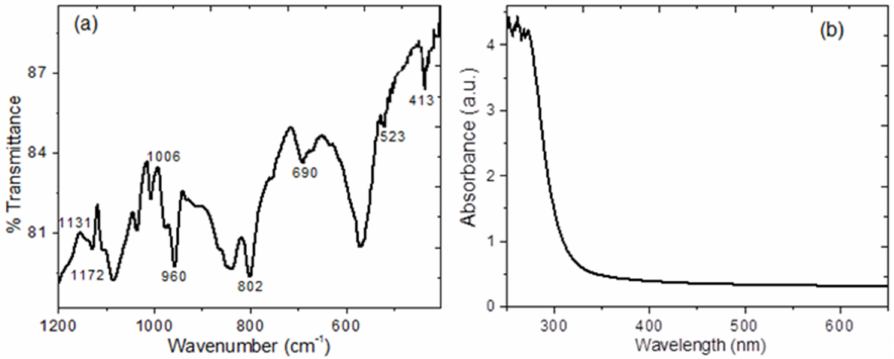
Figure 6. Spectra of ( a ) FTIR and ( b ) UV–Vis of PEDOT:PSS-CuBi 2 O 4 NP